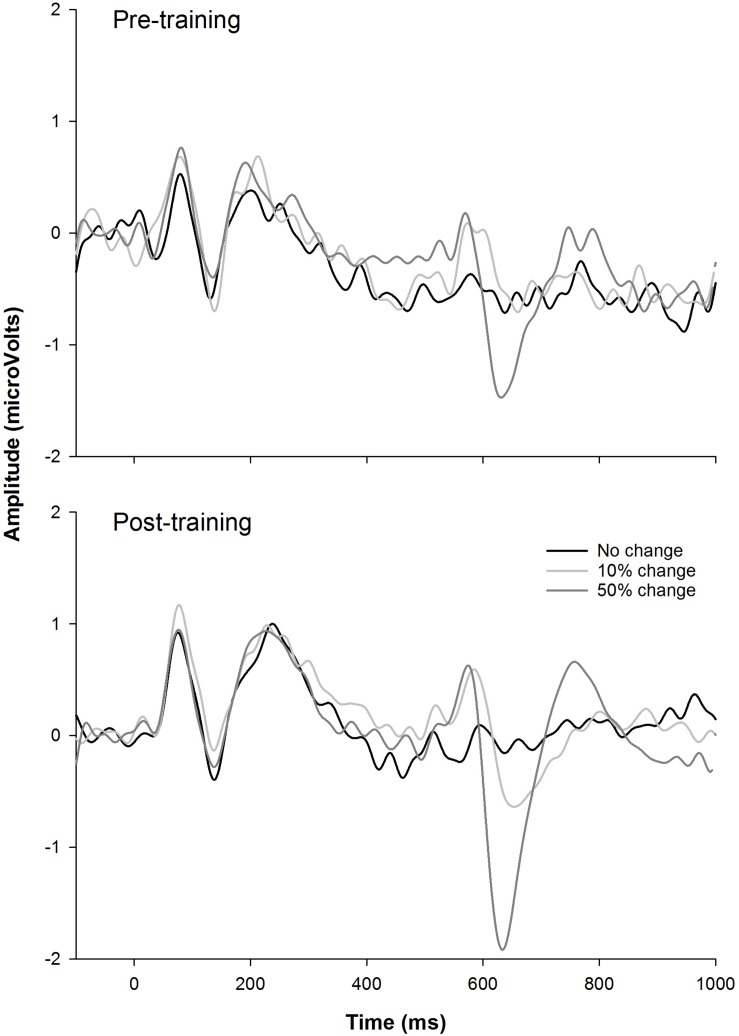
The mean EEG data from the nine participants. The responses to the tones containing a 0% frequency change (black), 10% change (light gray), and 50% change (dark gray) are plotted.